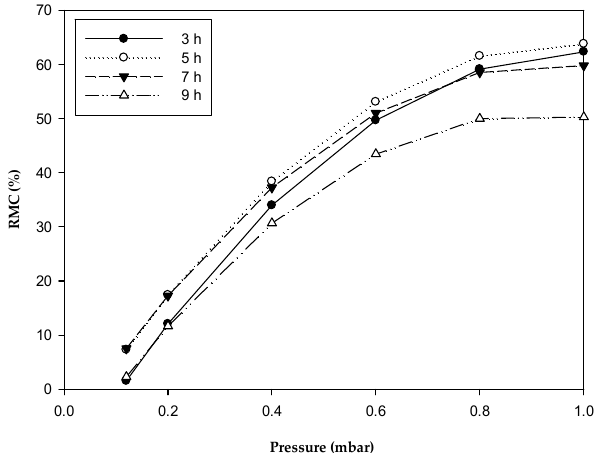
Figure 1. Predicted residual moisture content of dried MKG at different freezing time and pressure. 132